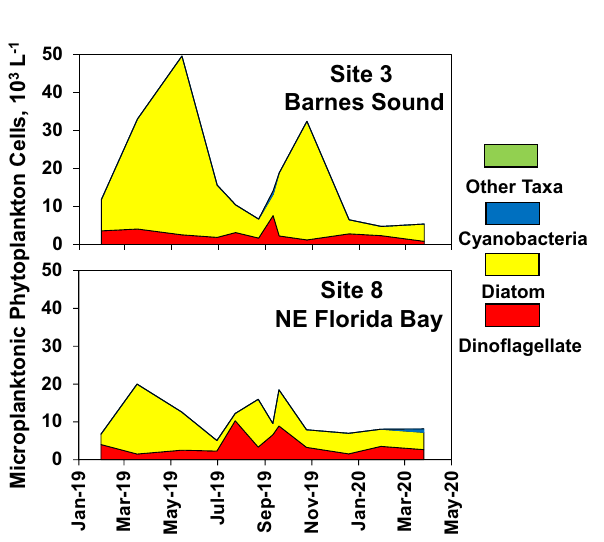
Figure 6. Salinities at Site 1 in Barnes Sound and Site 9 in N.E. Florida Bay from January 2019 through March 2020.